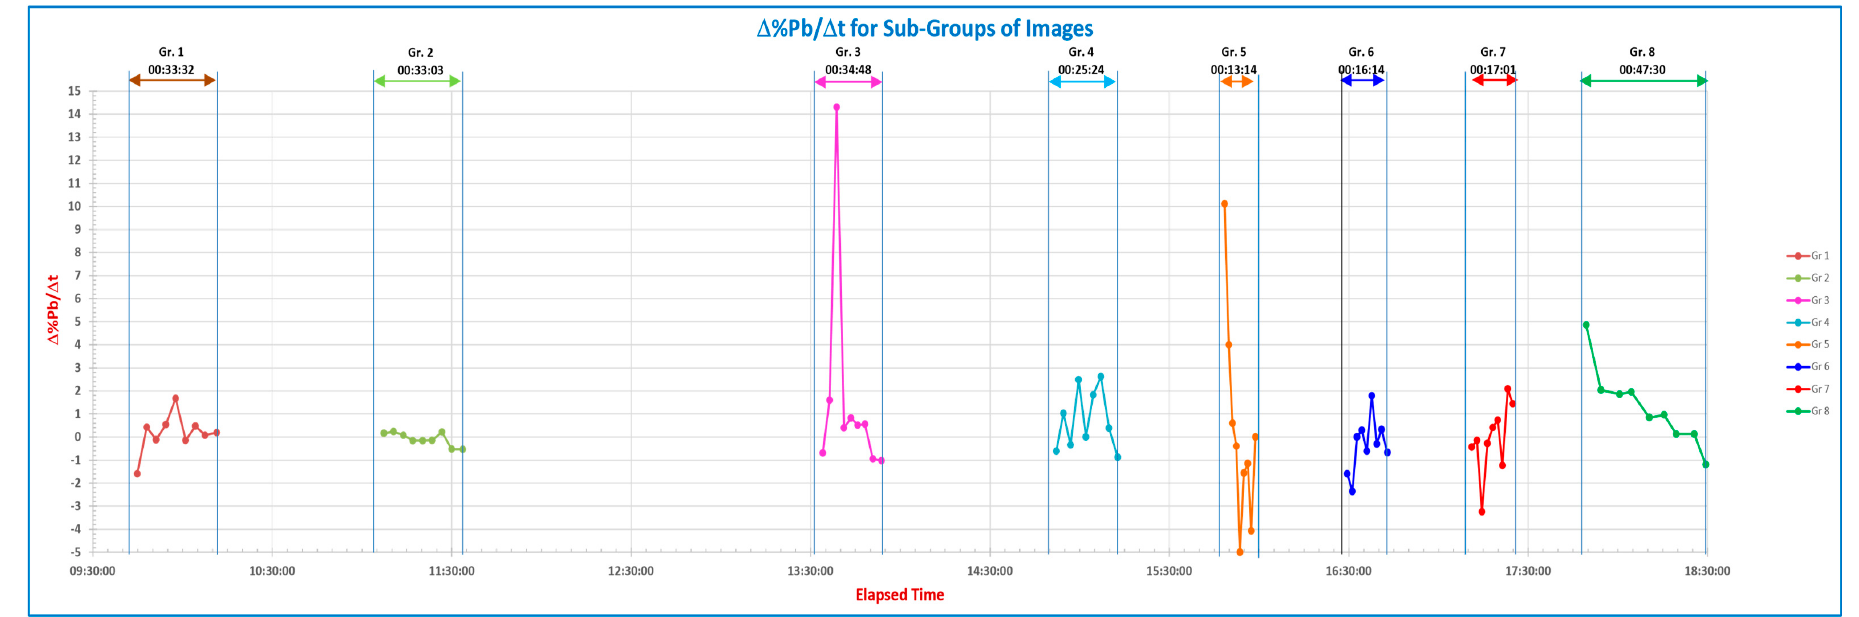
Figure 3. Variation in %Pb content versus time in the groups of flotation froth ( Δ %Pb/ Δ t) during the experiment.